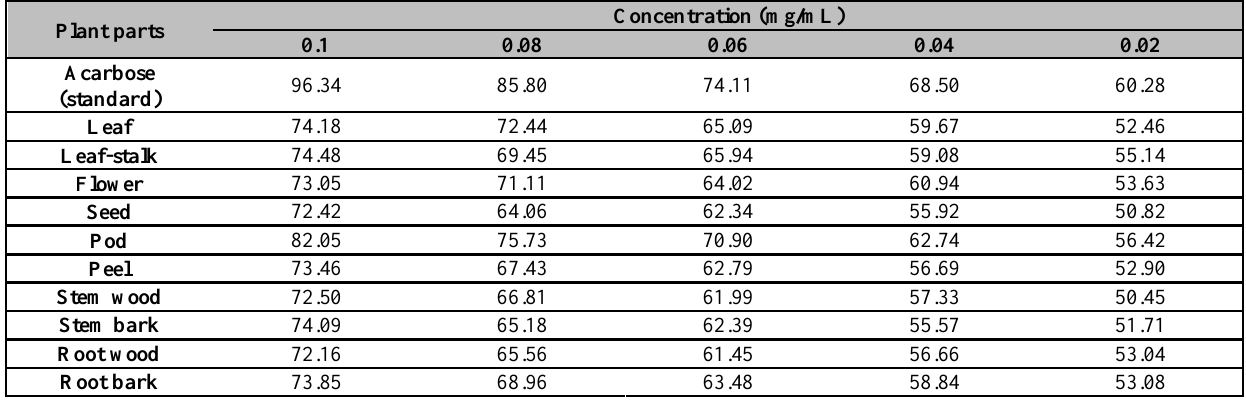
Table 2. Percentage α-glucosidase inhibition of essential oils from C. Inophyllum Linn Plant